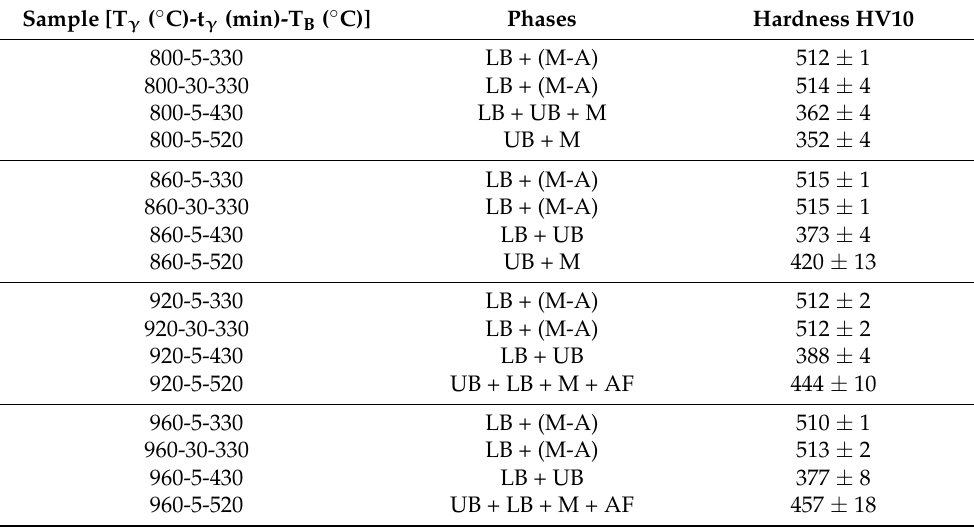
Table 3. List of phases and hardness (HV10) of samples after bainite